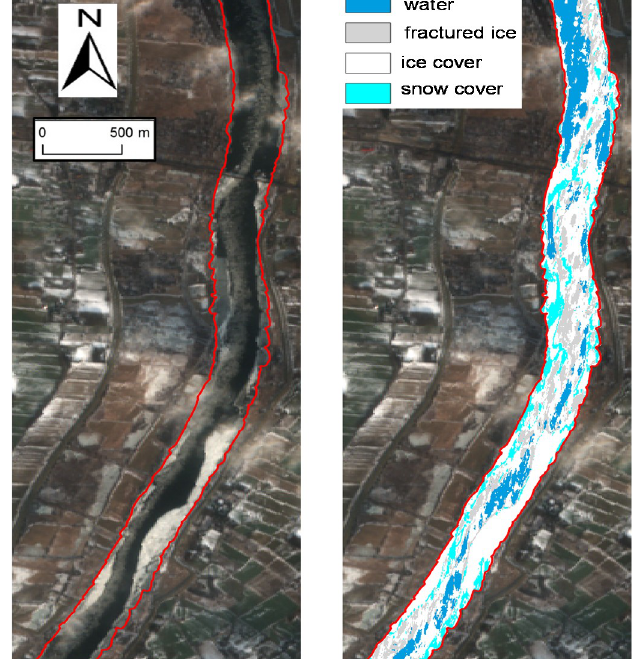
Figure 14. Comparison of Sentinel-2 RGB (red-green-blue) composition ( left panel ) and classification of Sentinel-1 data ( right panel ) (Lower Vistula River, acquired 31 January 2017). The bridge crosses the river at coordinates 54°15′21.03″ N, 18°56′45.94″ E.